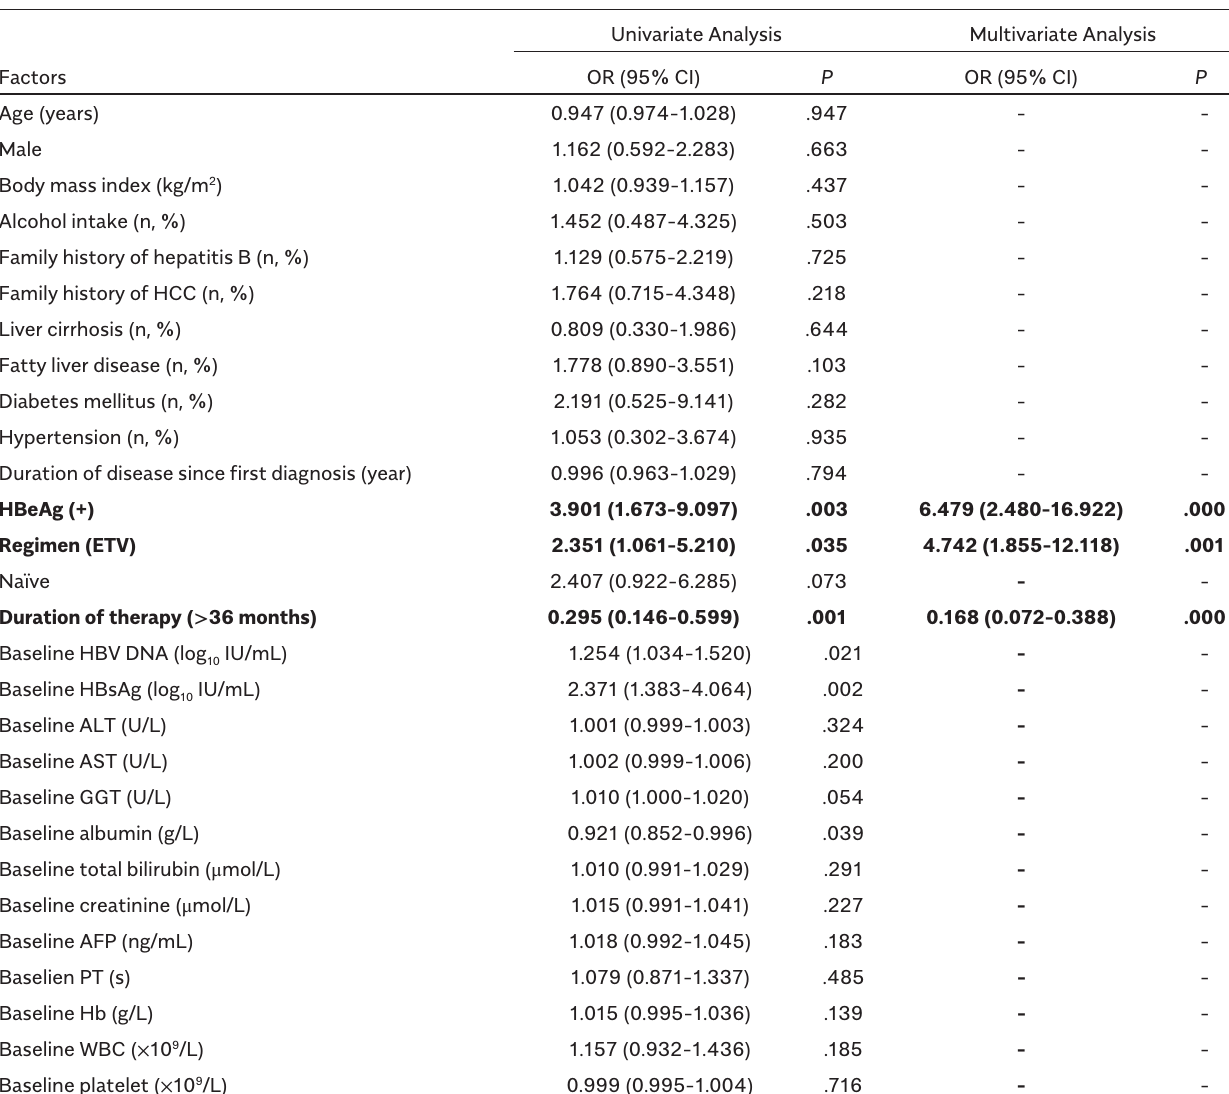
Table 2. Factors Associated with the Occurrence of LLV